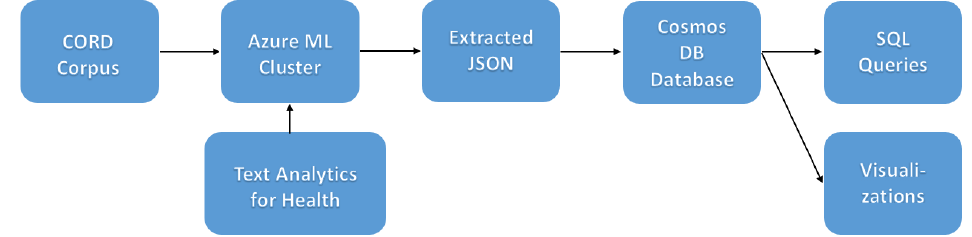
Figure 1. The architecture of the proposed system for scientific texts analysis.